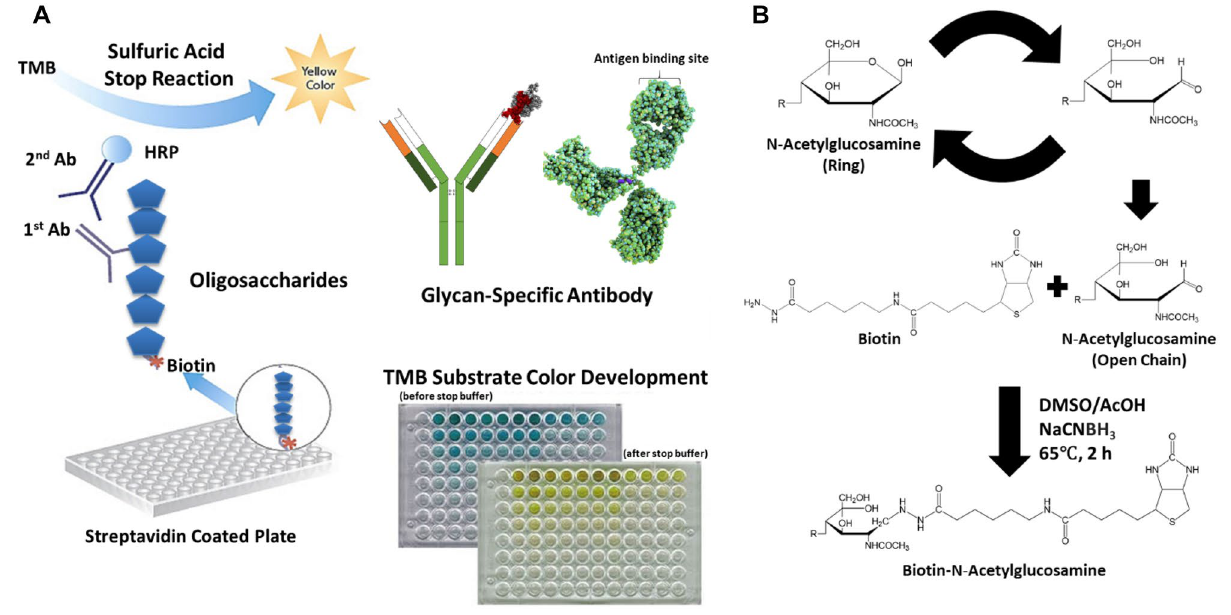
Figure 2. ELISA based monoclonal antibodies screening on biotinylated oligosaccharides. Here, ( A ) combining oligosaccharide biotinylation and subsequent ELISA screening on NeutrAvidin coated plates with glycan- directed mAbs and ( B ) one-step biotinylation procedure showing reaction product.